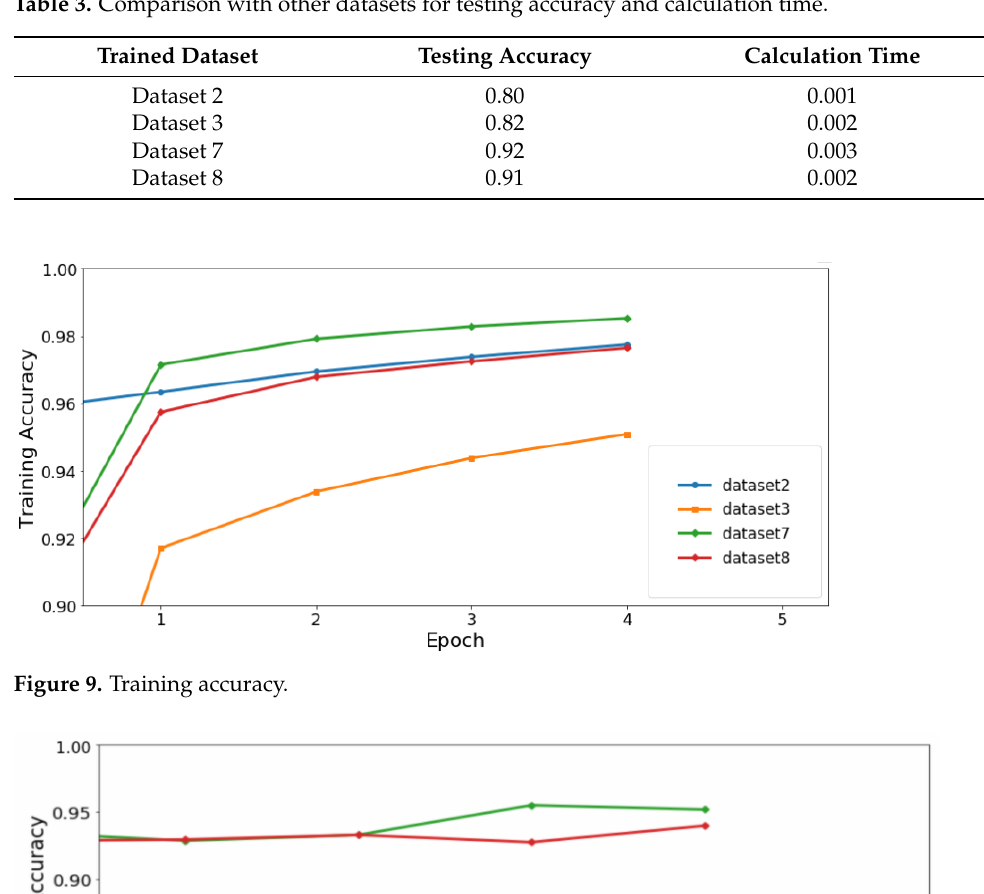
Table 3. Comparison with other datasets for testing accuracy and calculation time.